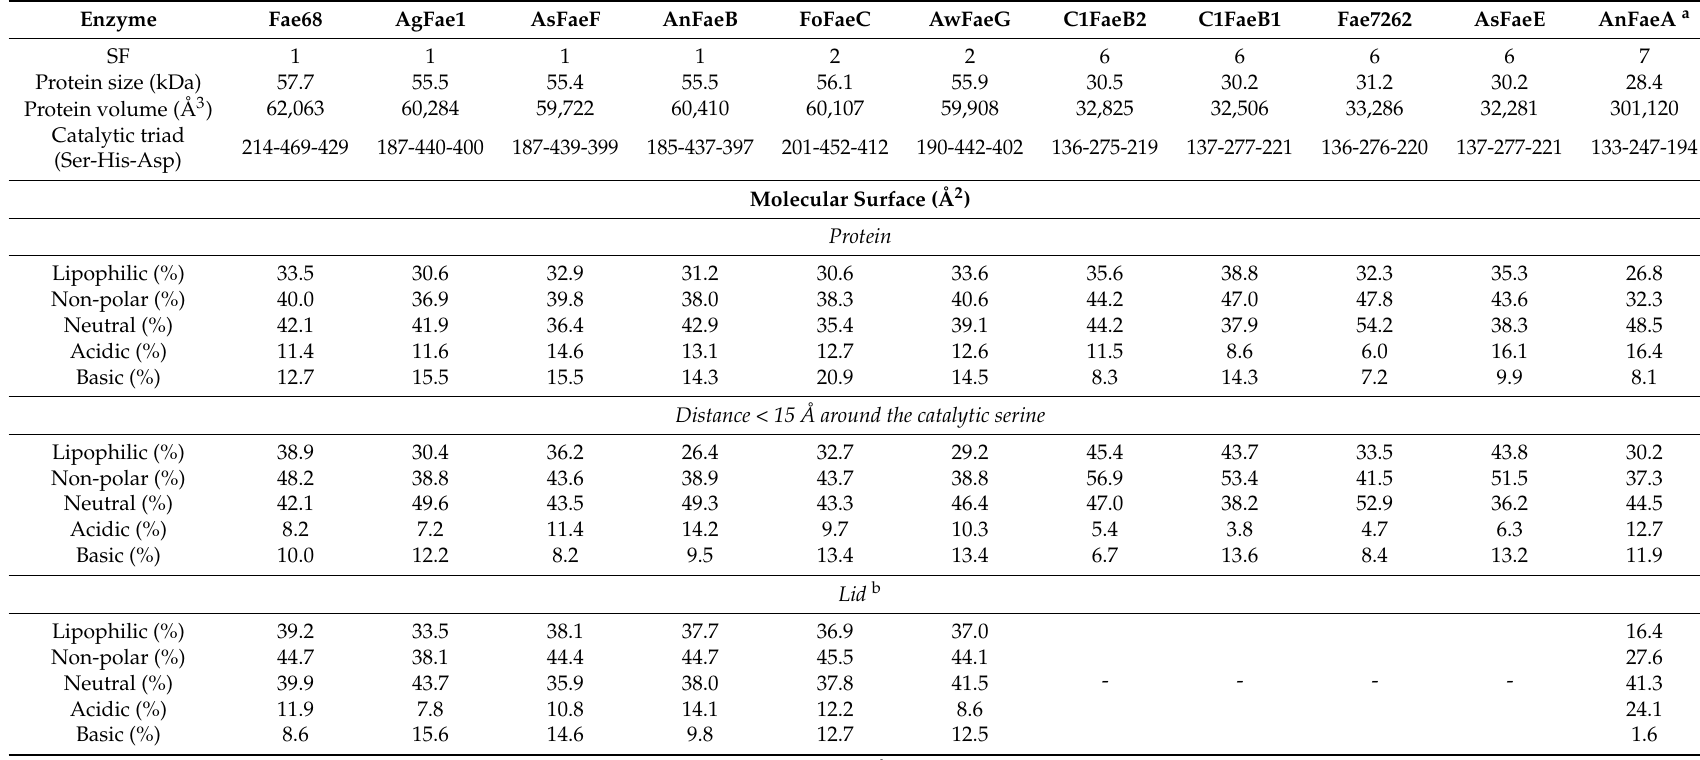
Table 4. Properties of SF1–2 and SF6–7 FAE-predicted